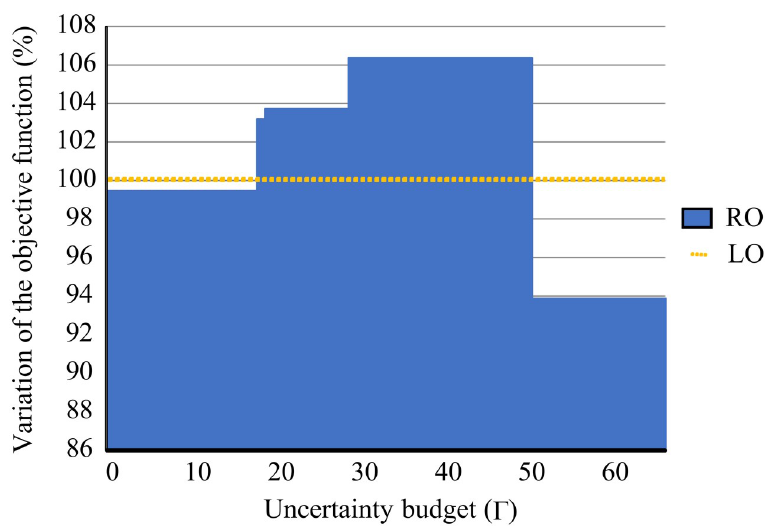
Fig 7. Objective function percentage value for different level of uncertainty budgets.